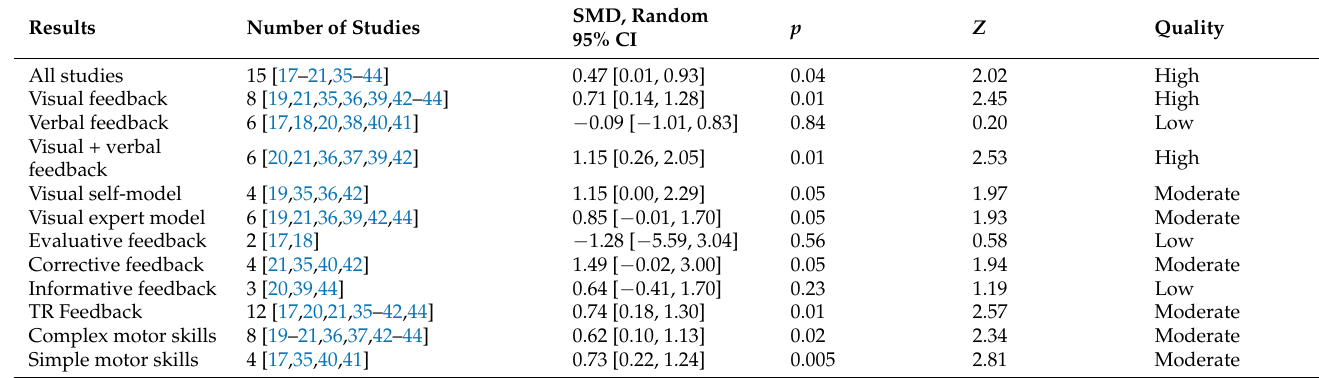
Table 3. The GRADE quality of evidence for primary outcome and sensitivity